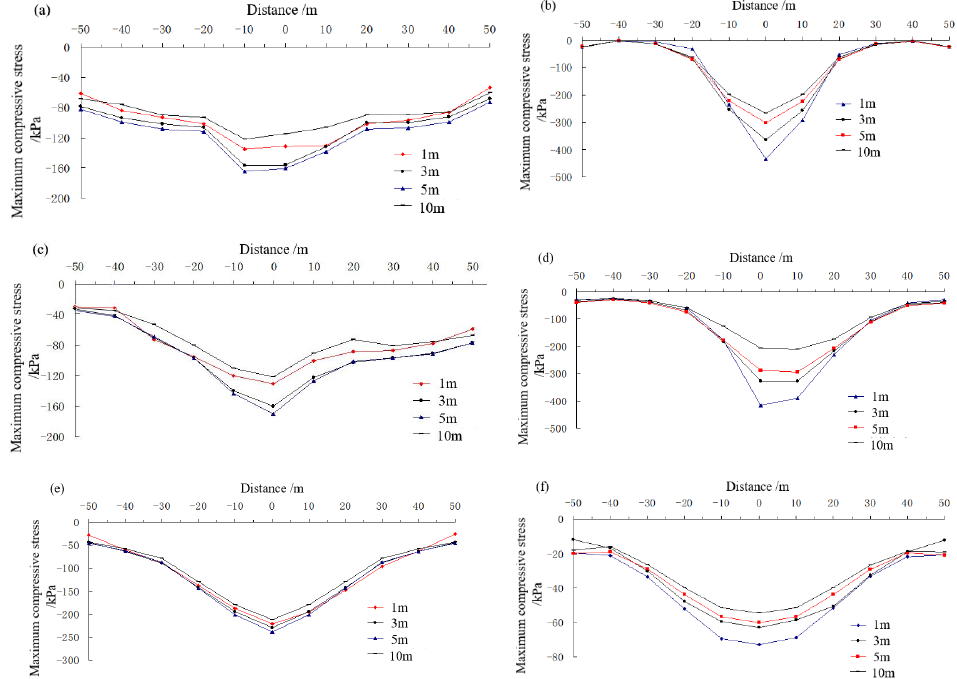
Figure 11. The maximum compressive stress, σ 3; distribution of secondary lining: ( a ) vault of upper